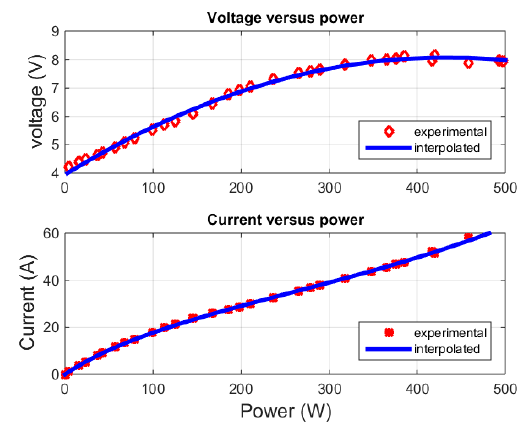
Figure 5. PEM-EL stack voltage and current versus the available power.